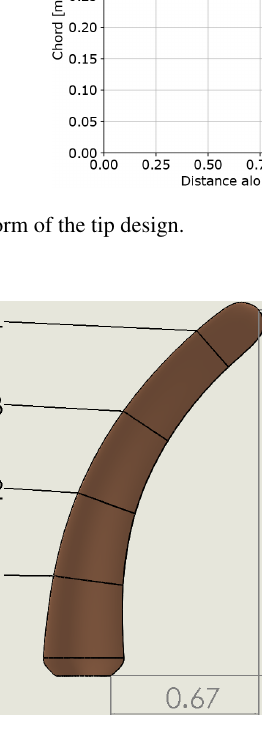
Figure 5. Three-dimensional geometry of the tip (in meters), indi- cating the four sections where pressure taps are